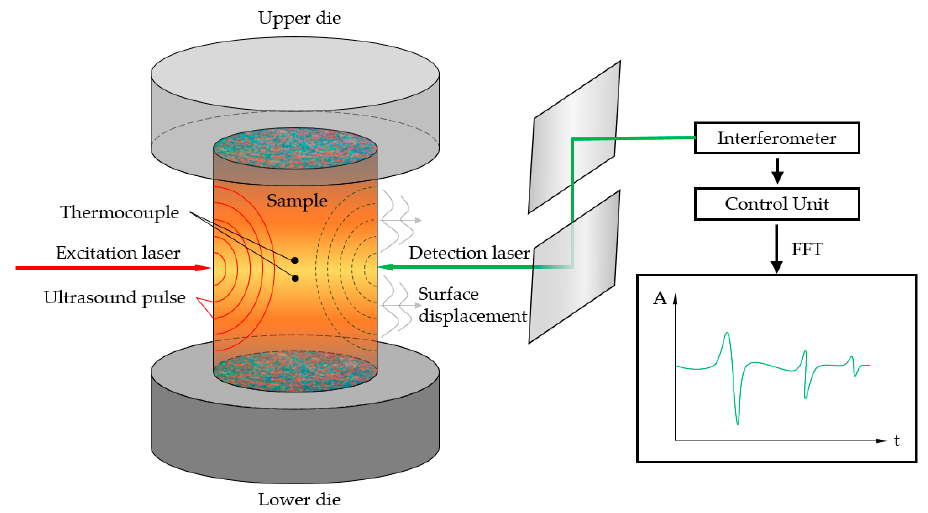
Figure 1. Schematic representation of the operating principle of a LUS System.